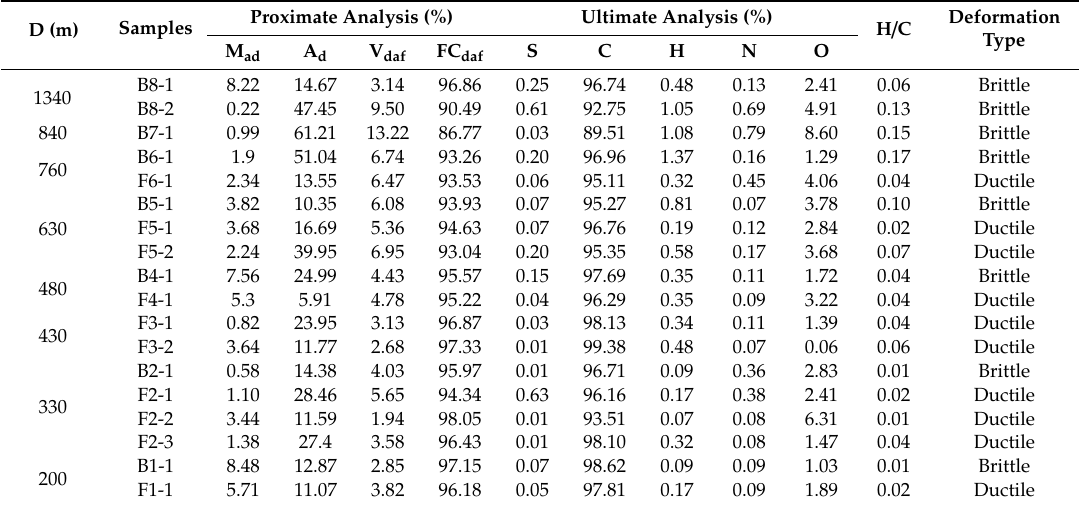
Table 1. Proximate and ultimate analysis of